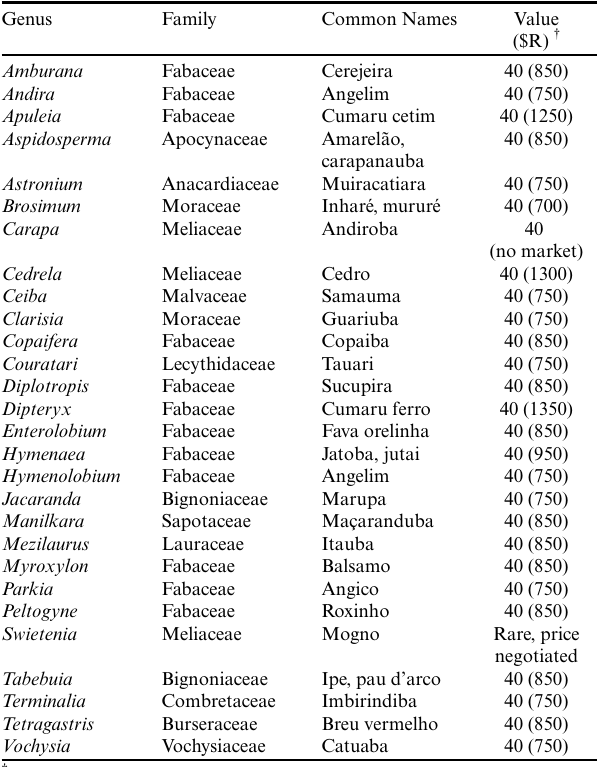
Table 2 . Major commercial timber genera, common names, and examples of 2012 market values from Acre, Brazil. Genera were included when cited as among those that could be sold consistently outside local communities. Shown are values paid to smallholders per cubic meter of standing roundwood before harvest, with sawnwood values in capital city sawmills